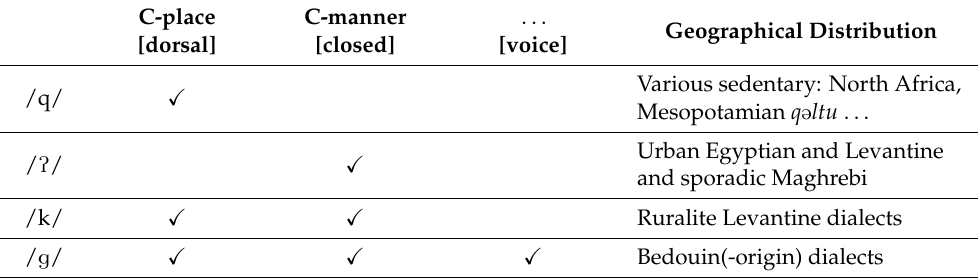
Table 1. Representational typology of the major * q phoneme